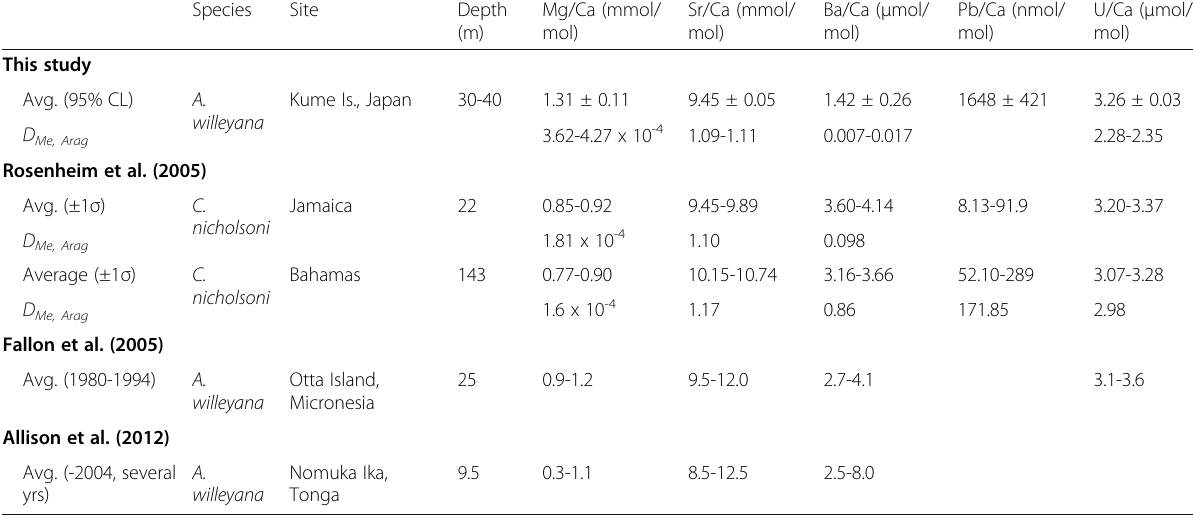
Table 3 Average elemental ratios and partition coefficients for aragonite sclerosponges Species